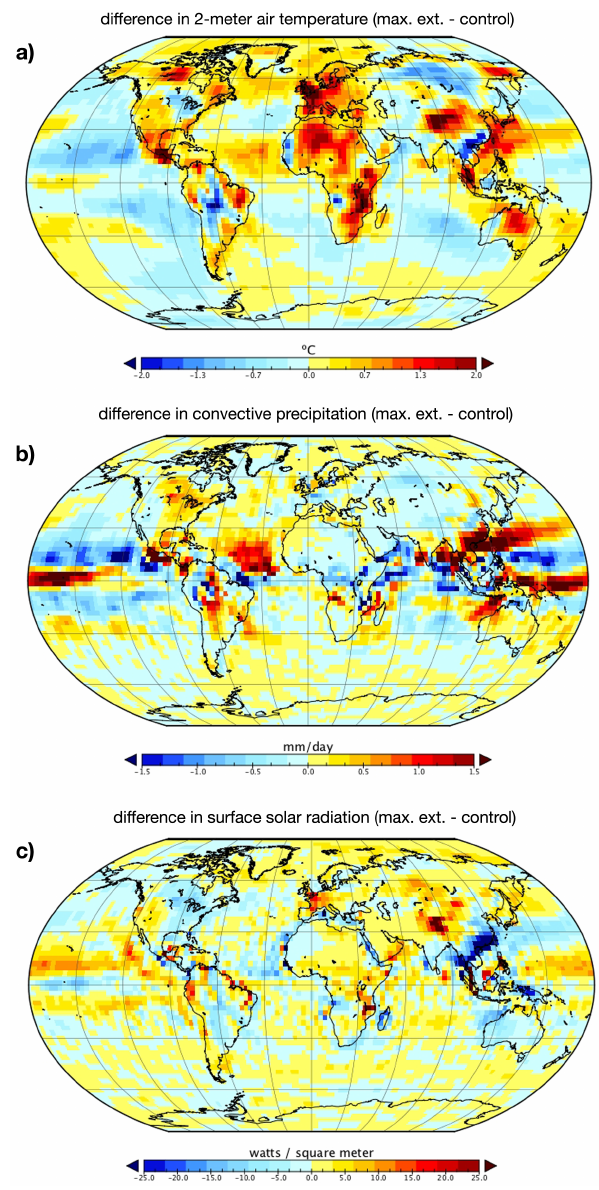
Fig. 9. The climatic consequences of large-scale wind power ex- traction is shown at T42 resolution with 20 vertical levels as a dif- ference between the mean maximum extraction and mean control simulations for (a) 2-m air temperature, (b) convective precipita- tion, and (c) surface solar radiation.